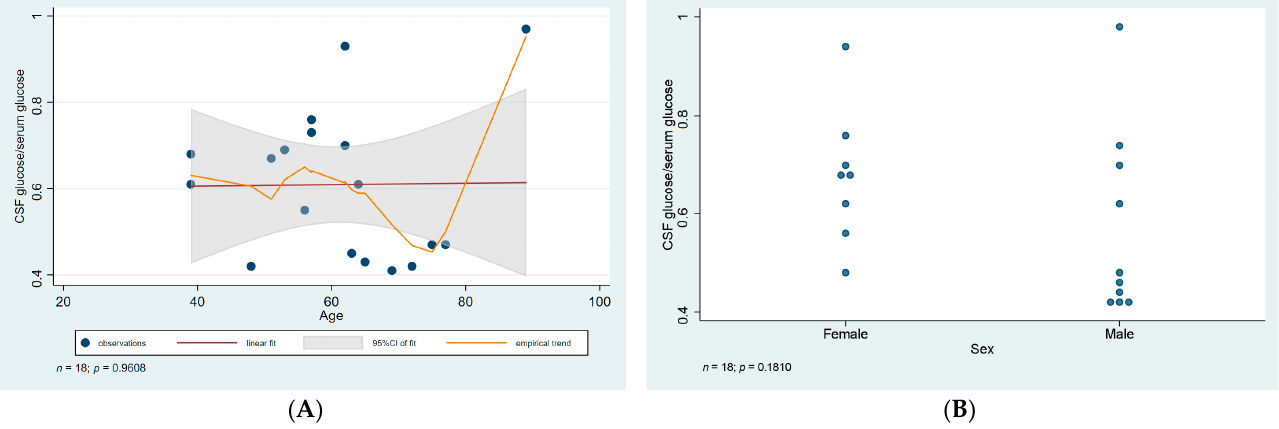
Figure 4. Statistical analysis of CSF glucose to serum glucose ratio. ( A ) Scatter plot of CSF/serum glucose ratio against age with linear regression fit and empirical trend superimposed. ( B ) Categorical scatter plot of the ratio by sex. CSF—cerebrospinal fluid; CI—confidence interval. Data was not available in the case of 5 patients.